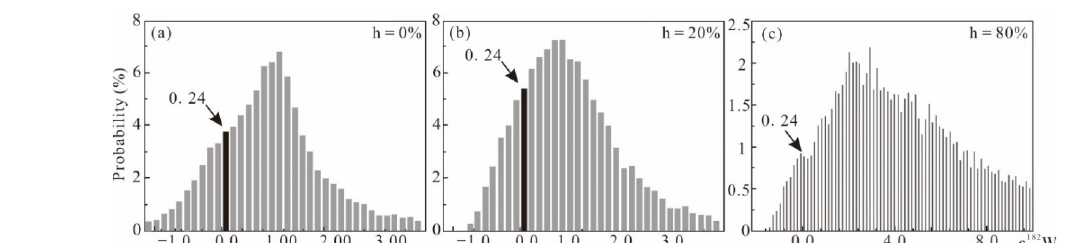
Figure 4. The lunar ε 182 W values in three impact scenarios and their occurrence probabilities (modified after [15]).